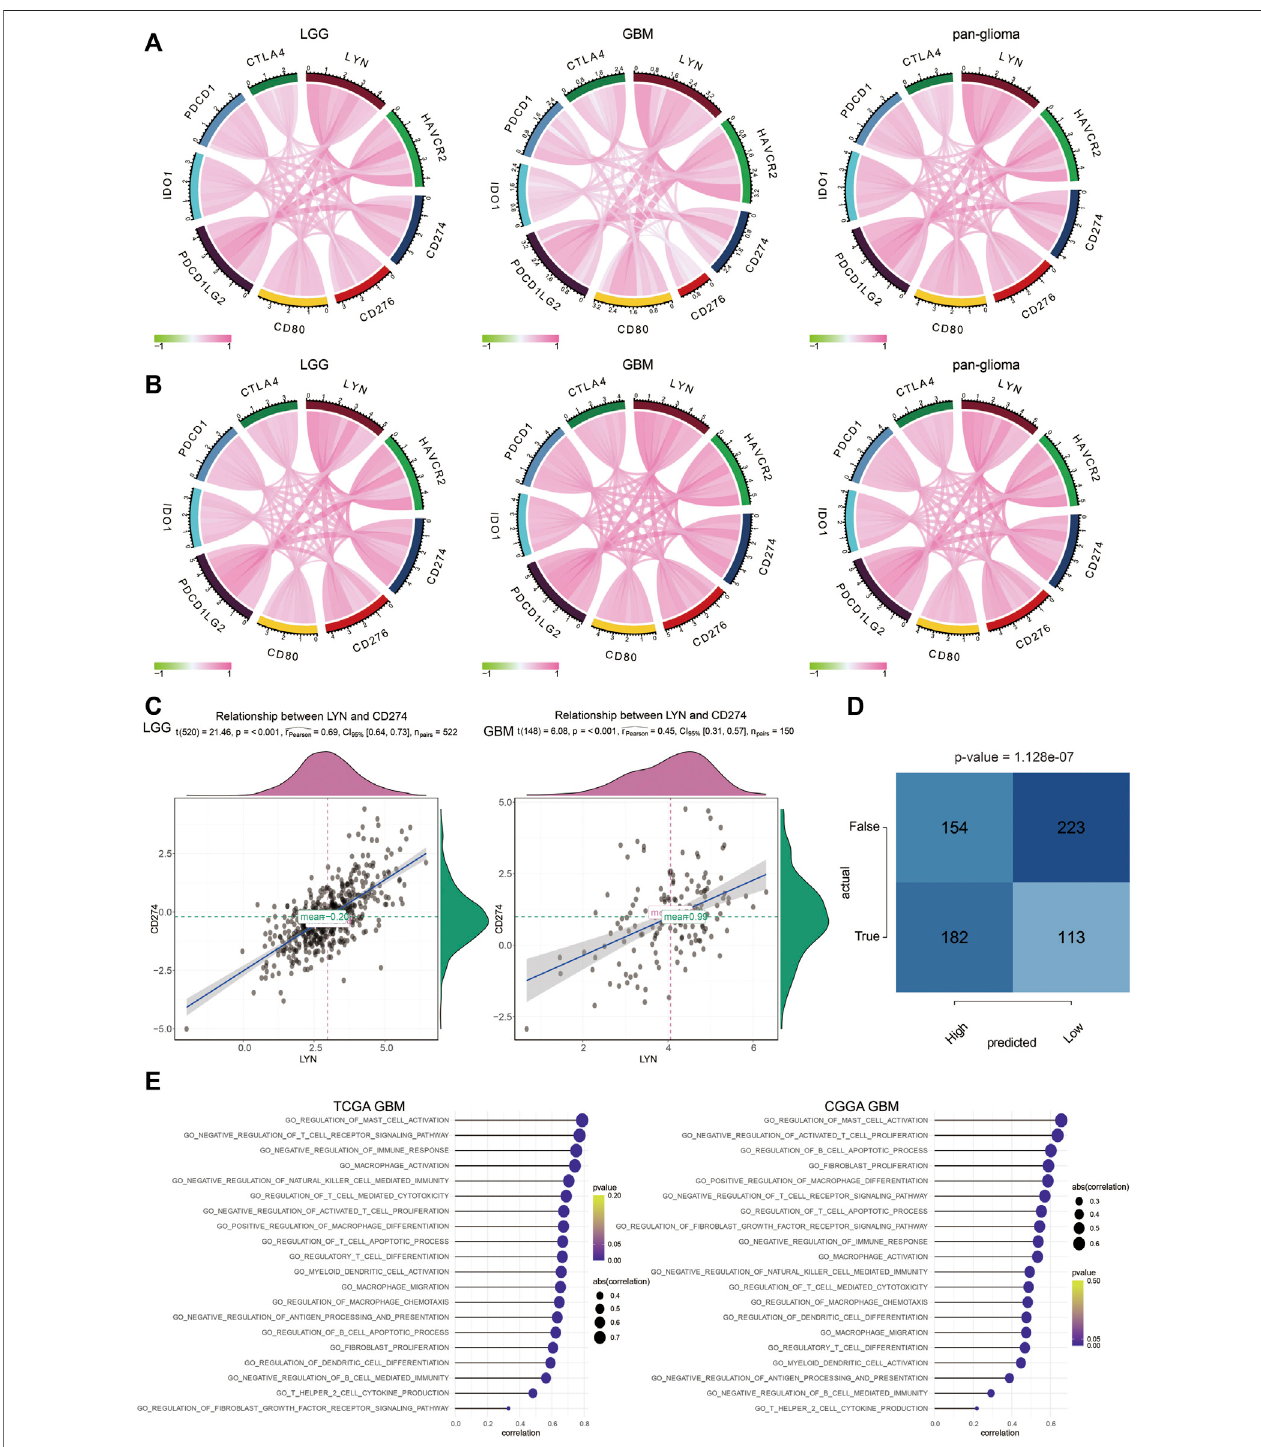
FIGURE 7 | LYN is associated with immunosuppressive activities (A) . The correlation between LYN and classical immune checkpoints in TCGA dataset (B) . The correlation between LYN and classical immune checkpoints in CGGA dataset (C) . The correlation between LYN and CD274 (PD-L1) in LGG and GBM in TCGA (D) . ContingencytableshowingthepredictivevalueofLYNexpressioninimmunotherapyresponsesbasedonTIDEalgorithm (E) .ThecorrelationbetweenLYNandimmune related signaling pathways in TCGA GBM and CGGA GBM samples in GO analysis.